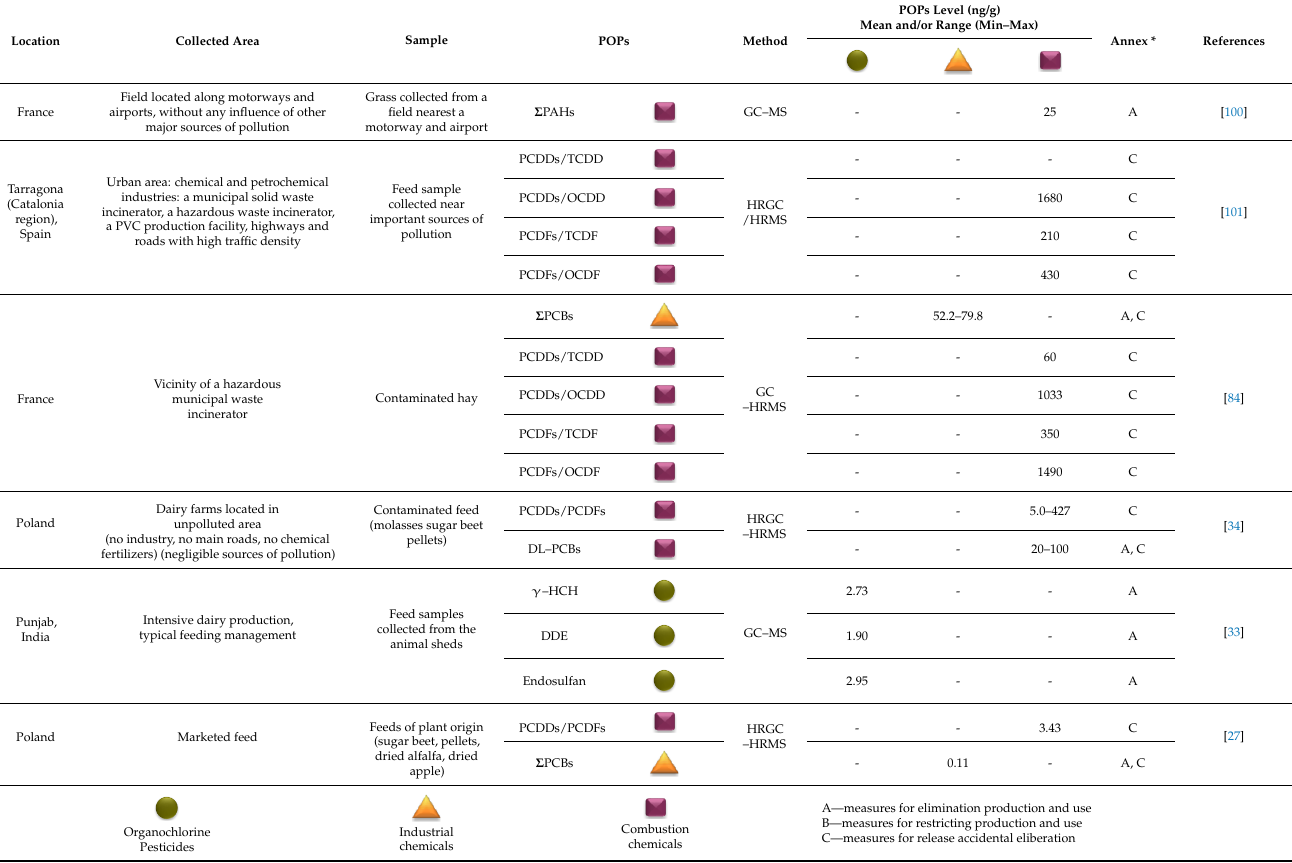
Table 3. Summary of POPs presence in animal feeds and sources of